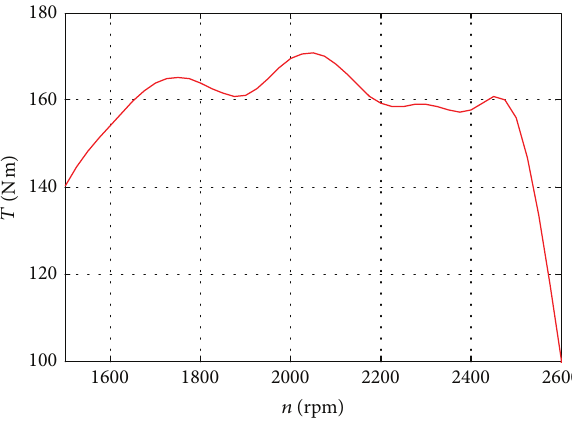
Figure 10: Maximum output torque of